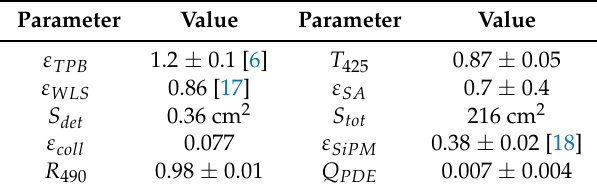
Table 1. Summary of parameters and their values used in PDE estimation.